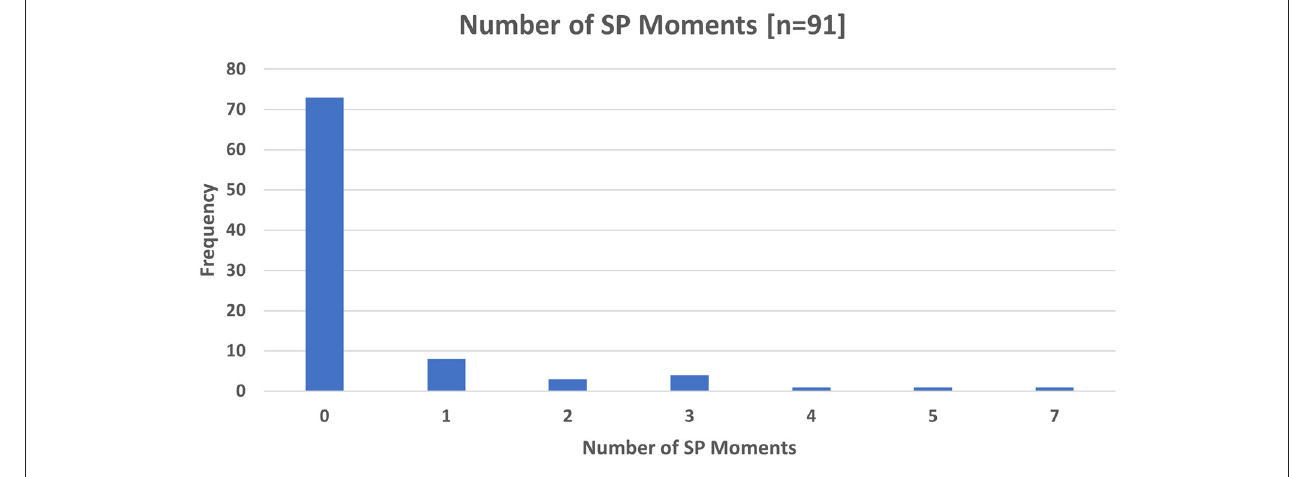
FIGURE 2 | Number of SP Moments at 6 months.